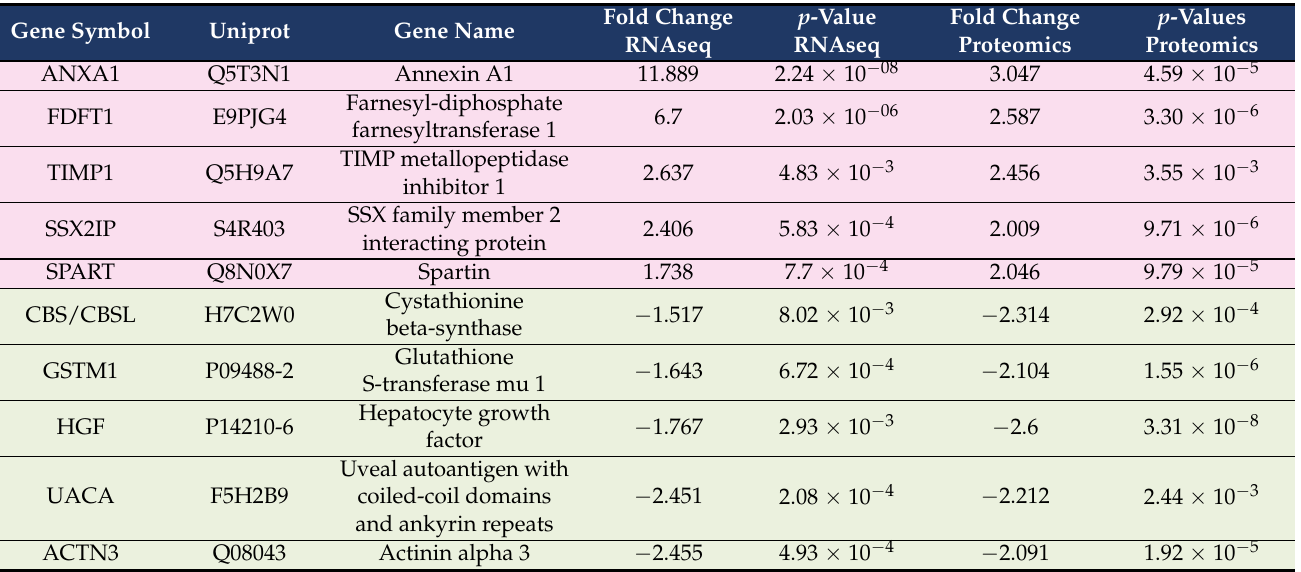
Table 8. Common differentially abundant genes at the RNA and protein levels in RBPMS SG2 vs. EV